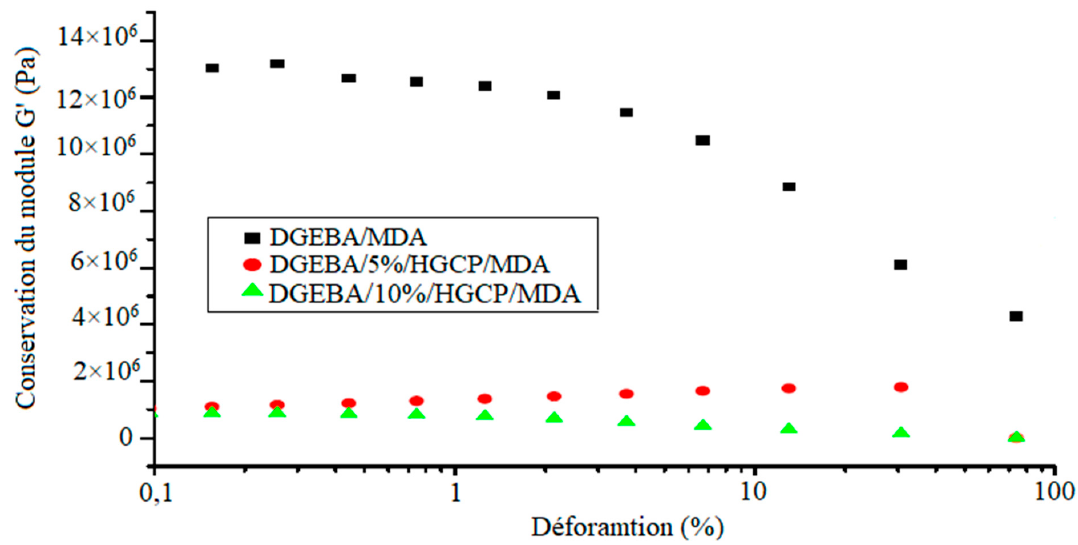
Figure 6. Conservation of the module G’ as a function of the deformation for the DGEBA/HGCP/MDA samples.